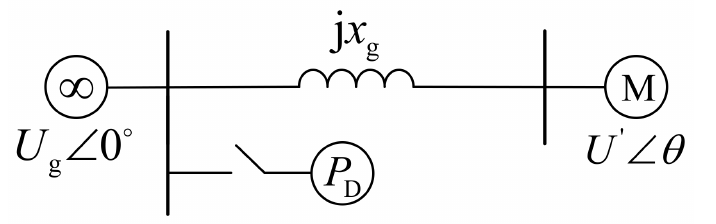
Figure 2. Single-machine infinite system structure.